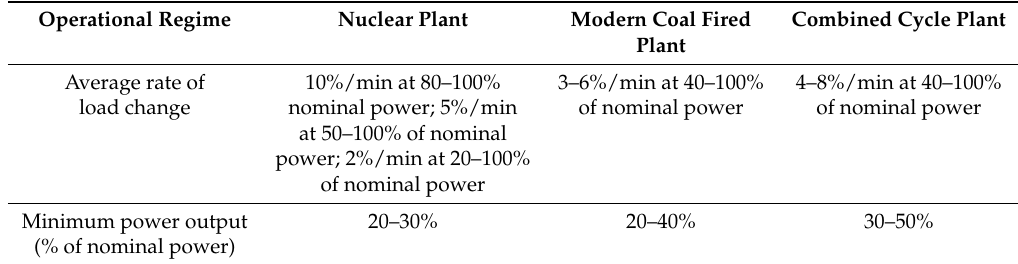
Table 1. Comparison of power manoeuvrability between nuclear, coal and gas-fired power plants